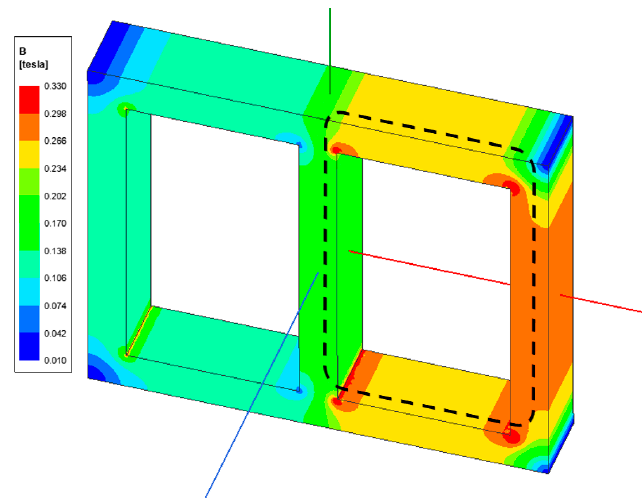
Figure 11. Magnetic flux density B magnitude on the core surface with the current excitation i 1 = − 2.76 A, i 2 = − 1.93 A, i 3 = 4.69 A; the dashed line indicates the magnetic flux path in the centre of the core.